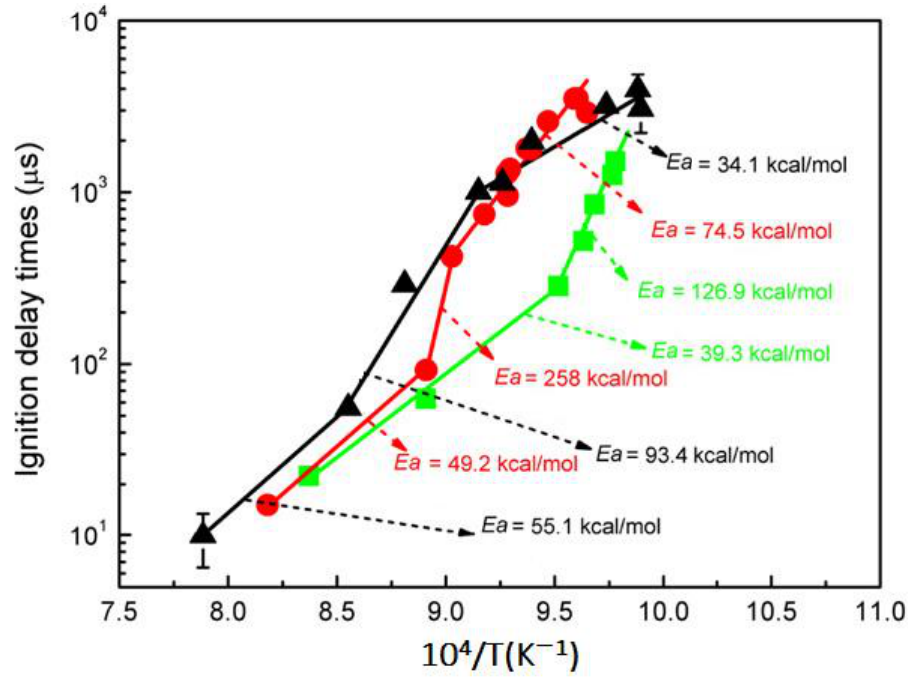
Figure 8. Temperature dependence of autoignition delay time for hydrogen at various pressures. ( ■ ) — P = 0.5 MPa; (●)— P = 1.0 MPa; ( ▲ ) — P = 2.0 MPa (adapted from [24]).